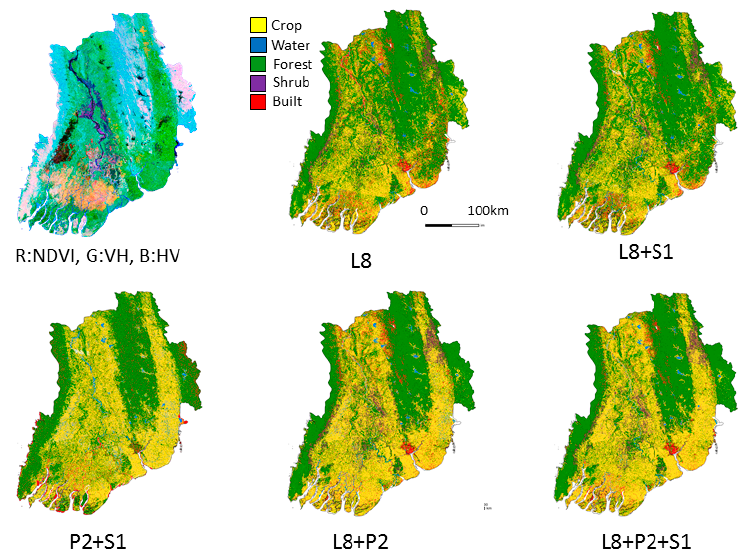
Figure 9. False color (R: Landsat NDVI, G: Sentinel-1 VH, B: PALSAR-2 HV) and classification outcomes for Irrawaddy Delta using different combinations of Landsat-8 OLI (L8), Sentinel-1, and PALSAR-2.